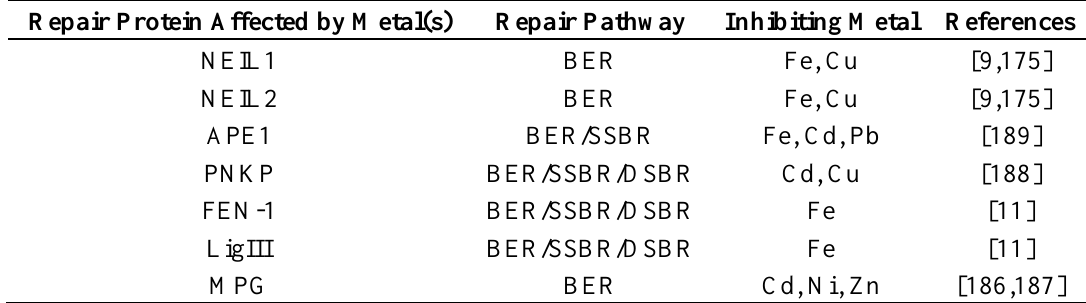
Table 2. Key genome repair enzymes affected by metals. Transition and heavy metals have been shown to inhibit the repair activities of key proteins involved in the BER, single-strand break repair (SSBR) and DSBR pathways.